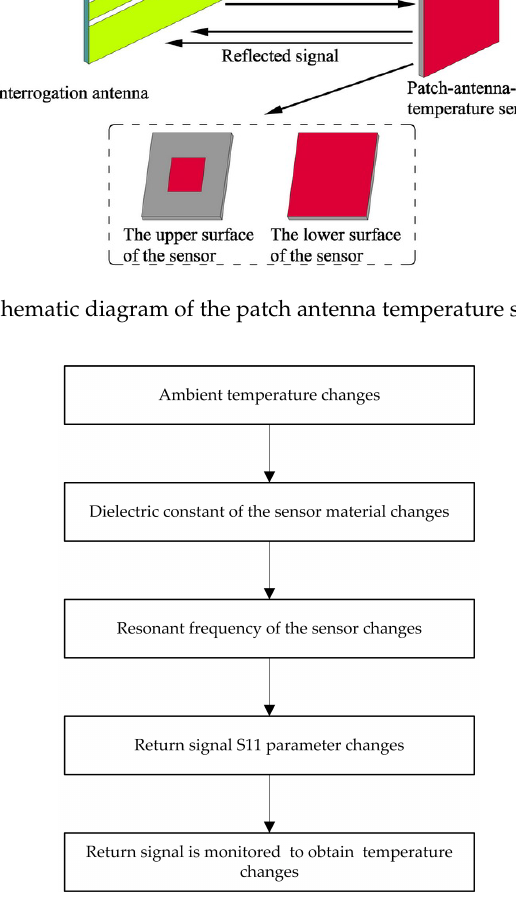
Figure 2. Patch antenna-type temperature sensor measurement process.